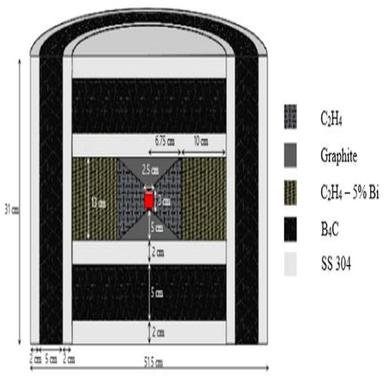
Reference shield design geometry.